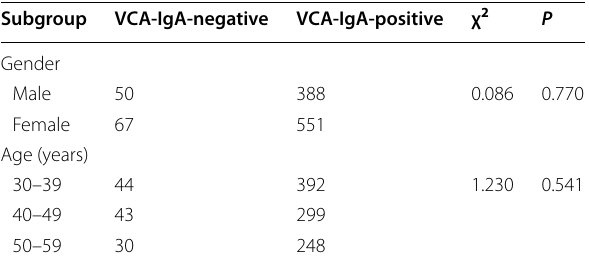
Table 2 Baseline VCA-IgA-positive and -negative